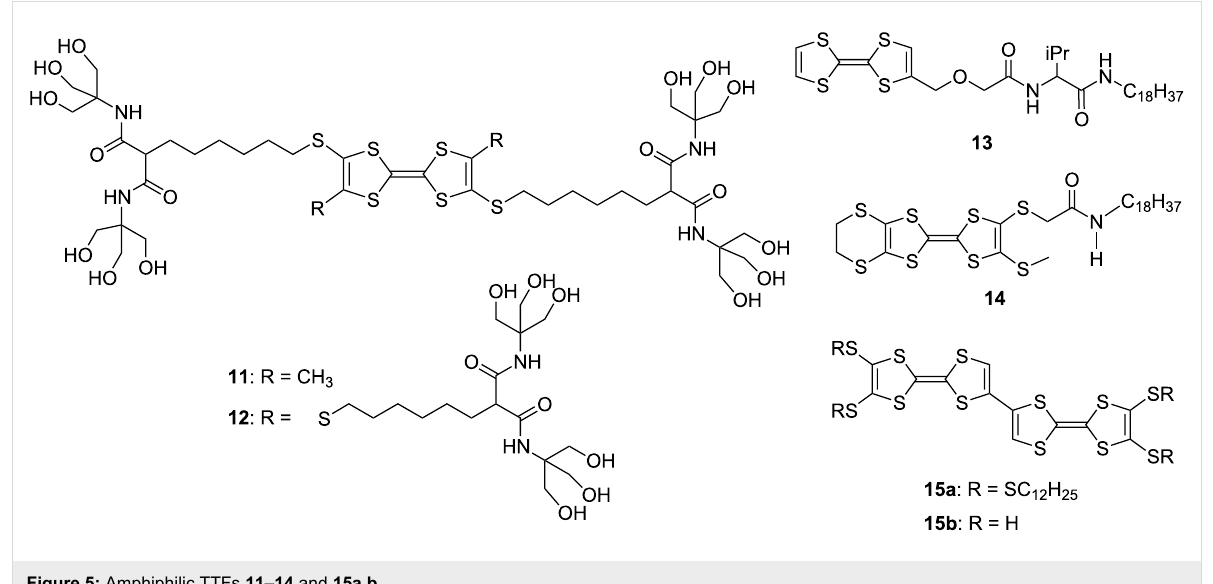
Figure 5: Amphiphilic TTFs 11–14 and 15a , b .